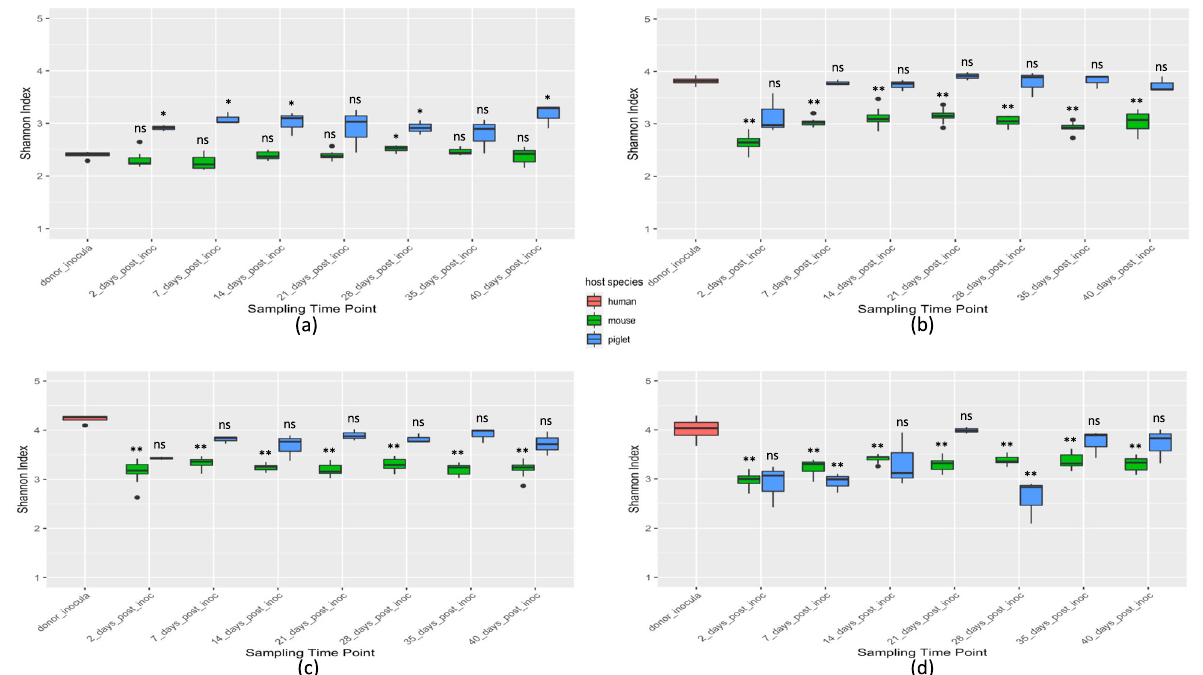
Fig. 4 Box-whisker plots depicting the variation in alpha diversity between the donor inocula and the HMA animal fecal samples at each sampling time point. ( a ) Donor_1, ( b ) Donor_2, ( c ) Donor_3, and ( d ) Donor_4. The box represents the 25th and 75th percentiles as the interquartile range (IQR) and the short black line represents the median. The whiskers represent the minimum and maximum values. Outliers are shown as black dots. Statistical comparisons are based on the Wilcoxon rank-sum test. * p < 0.05; ** p < 0.01; ns – not signi fi cant. n = 13 (3 piglets/donor, with the exception n = 4 for Donor_1, 2 days post inoculation) and n = 37 mice (Donor_1 = 7, Donor_2 = 10, Donor_3 = 10, Donor_4 =